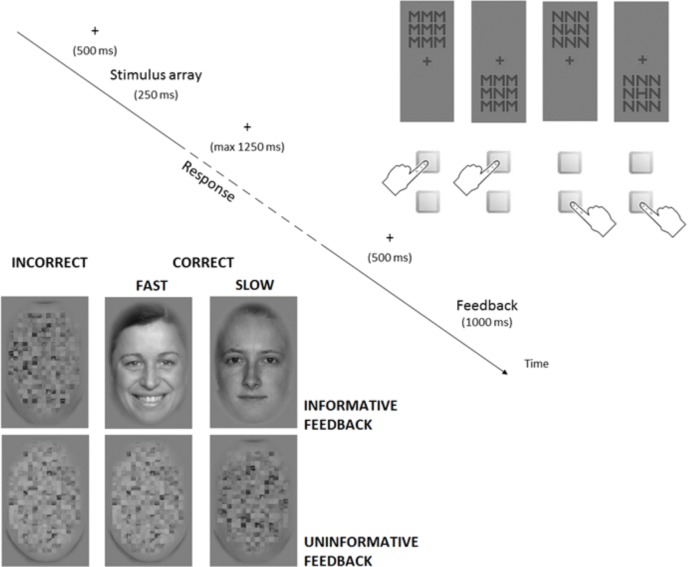
Design of the response-choice task.Schematic representation of the response-choice task, the time course of trials, and the stimuli used as external signals in the conditions with informative and uninformative feedback.